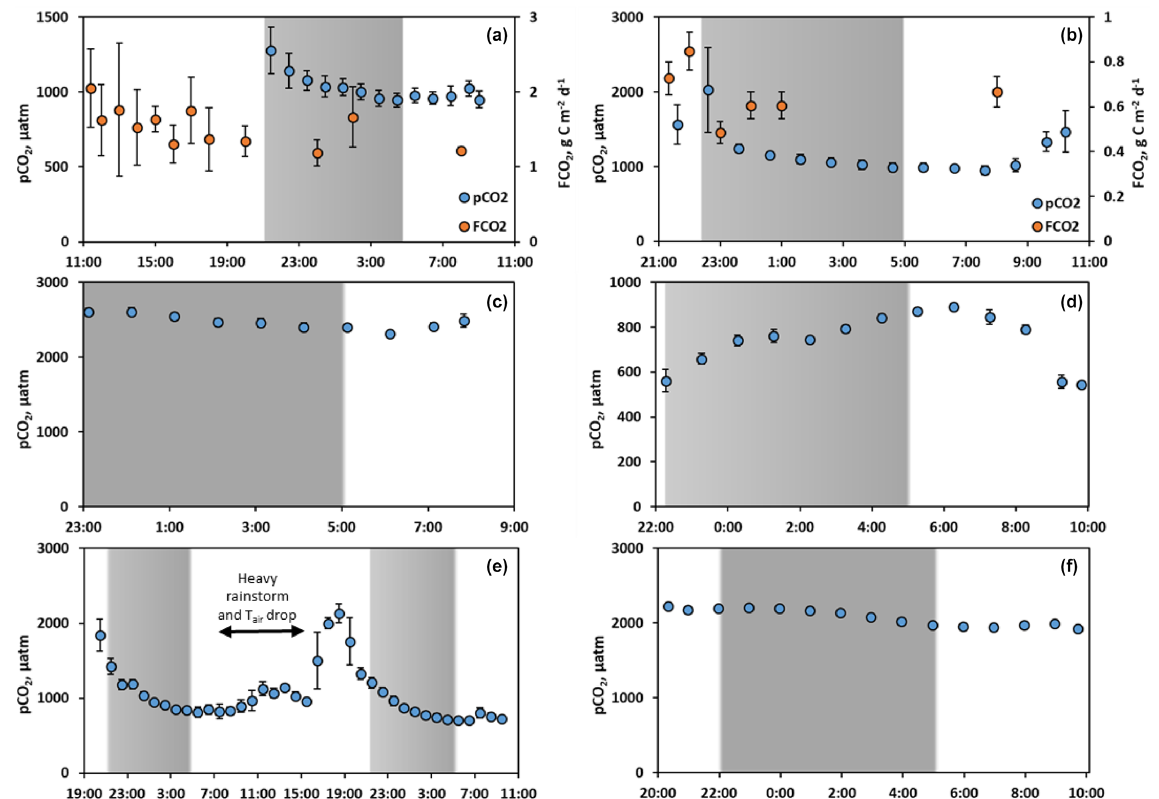
Figure 4. Continuous p CO 2 concentration ( a–f , blue circles) and chamber-based fluxes (a, b) measured during the spring flood period in tributaries ( a Sochur No. 3, b Lopatka No. 8, c Derevyannaya No. 12, d Ob River entrance, e Segondenka No. 26) and in the Ket River main stem (middle course) near Stepanovka (f) , including nighttime measurements (shaded area). The measurement frequency was one per hour. Variations in water temperature were within the range of 0.3 to 0.6 ◦ C and did not exhibit significant correlations with p CO 2 and F CO 2 . Note that, for the small river Segondenka ( S watershed = 472km 2 ), where the CO 2 peak was observed at 19:00 (e) , there was quite heavy rainfall between 07:00 and 15:00.